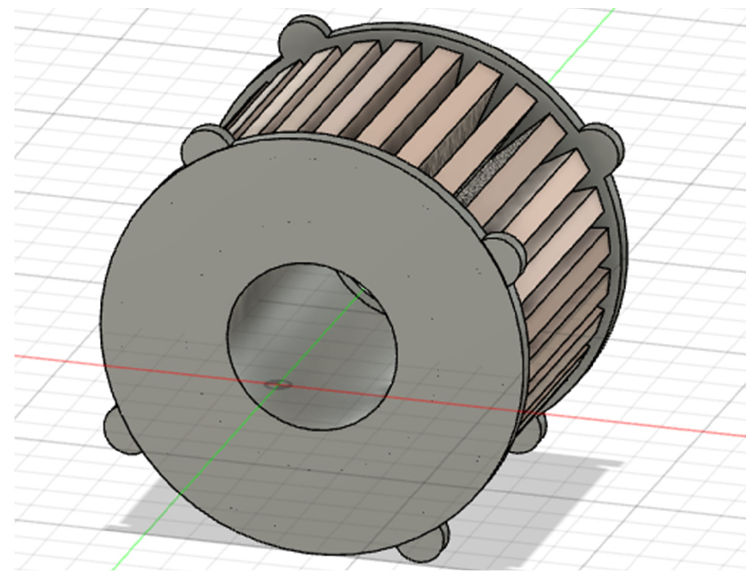
Figure 9. The stator of motor.